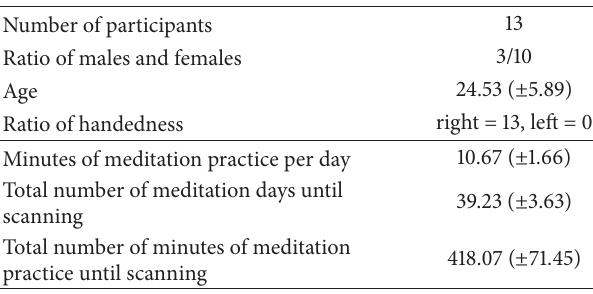
Table 1: Characteristics of the subject sample. Wherever relevant, group mean ( ± standard deviation) is